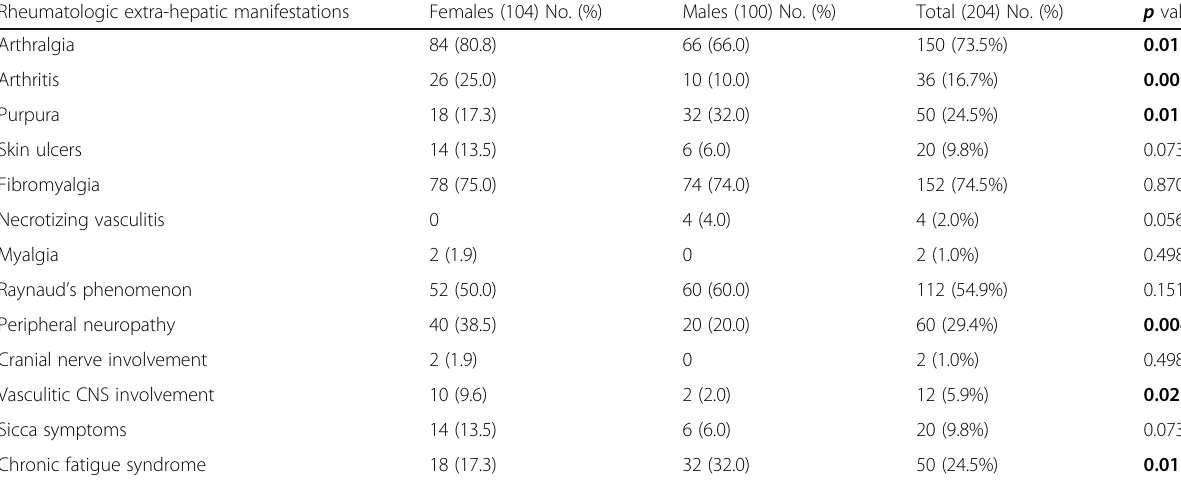
Table 2 Comparison of extra-hepatic manifestations between females and males Rheumatologic extra-hepatic manifestations